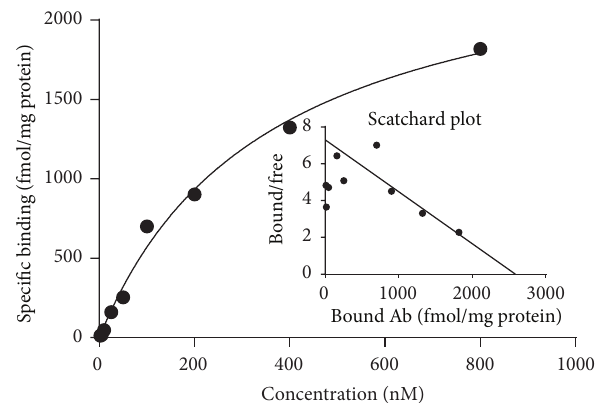
Figure 6: Cell binding assay with 64 Cu-DOTA-11-25 mAb. BxPC-3 cells were transferred to 24-well plates at 5 × 10 4 cells/well/mL and cultured for 4 days. Various concentrations of 64 Cu-DOTA-11-25 mAb were incubated with the cell monolayers for 2 hours on ice in complete growth media (RPMI-1640 medium containing 10% fetal bovine serum). The cells were washed and lysed and their radioactivity was counted in a 𝛾 -counter. Inner graph showed the Scatchard plot of the specific binding versus the concentration of 64 Cu-DOTA-11-25 mAb.